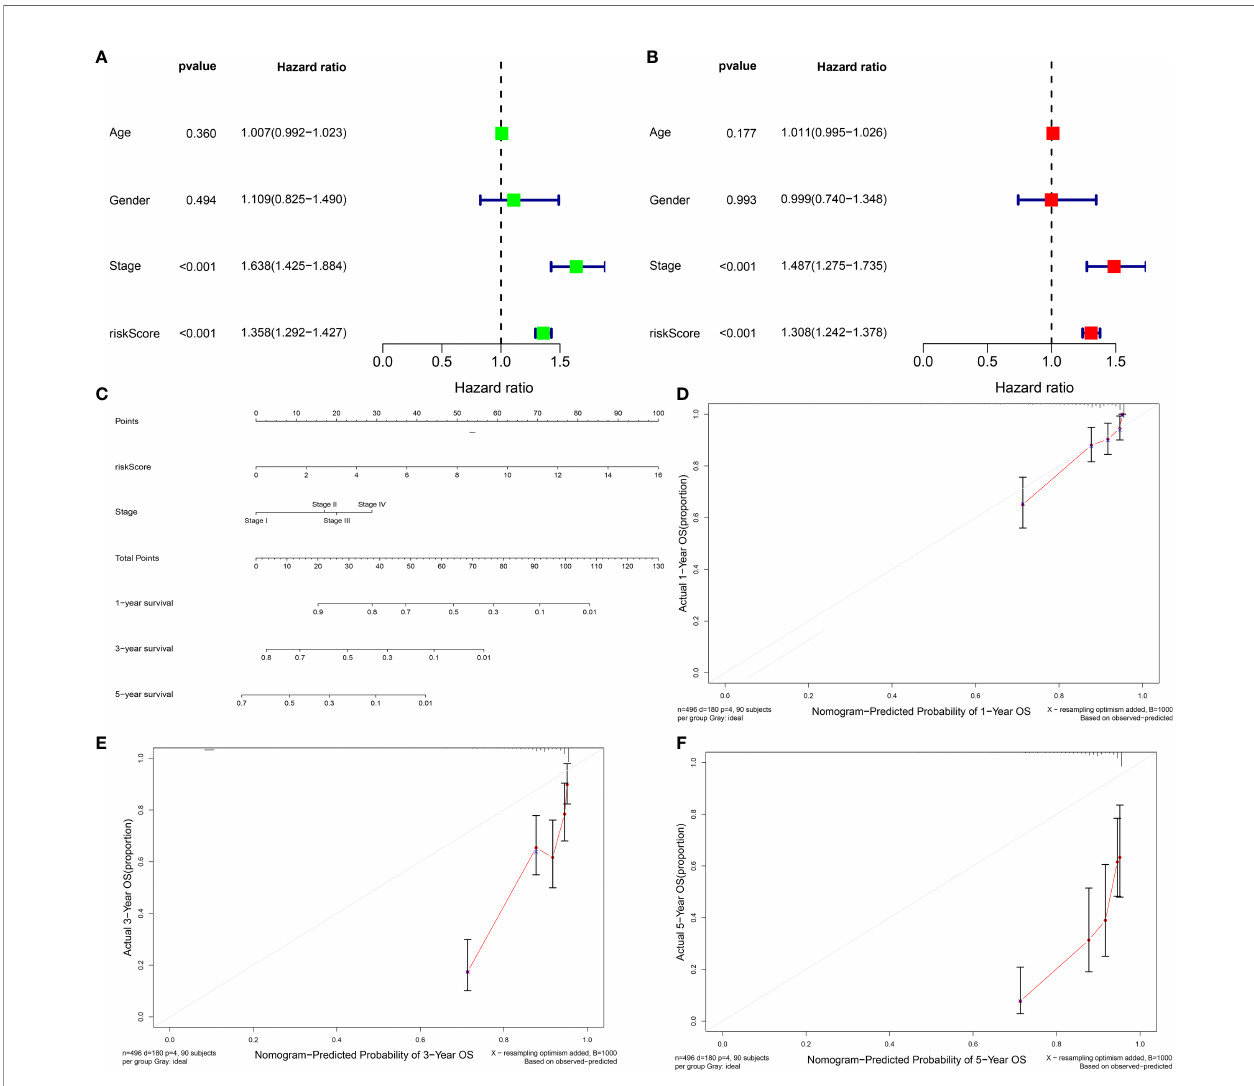
FIGURE 4 | Evaluation of the independence of prognostic model in prognostic prediction and construction of prognostic nomograms for LUAD. (A, B) Univariate and multivariate Cox analysis of risk score and clinicopathological features with LUAD prognosis. (C) The nomogram of risk score signature and stage for prediction of 1-, 3-, and 5-year OS of LUAD. (D – F) Calibration curves used to compare nomogram estimated 1-, 3-, and 5-year survival probabilities with actual survival